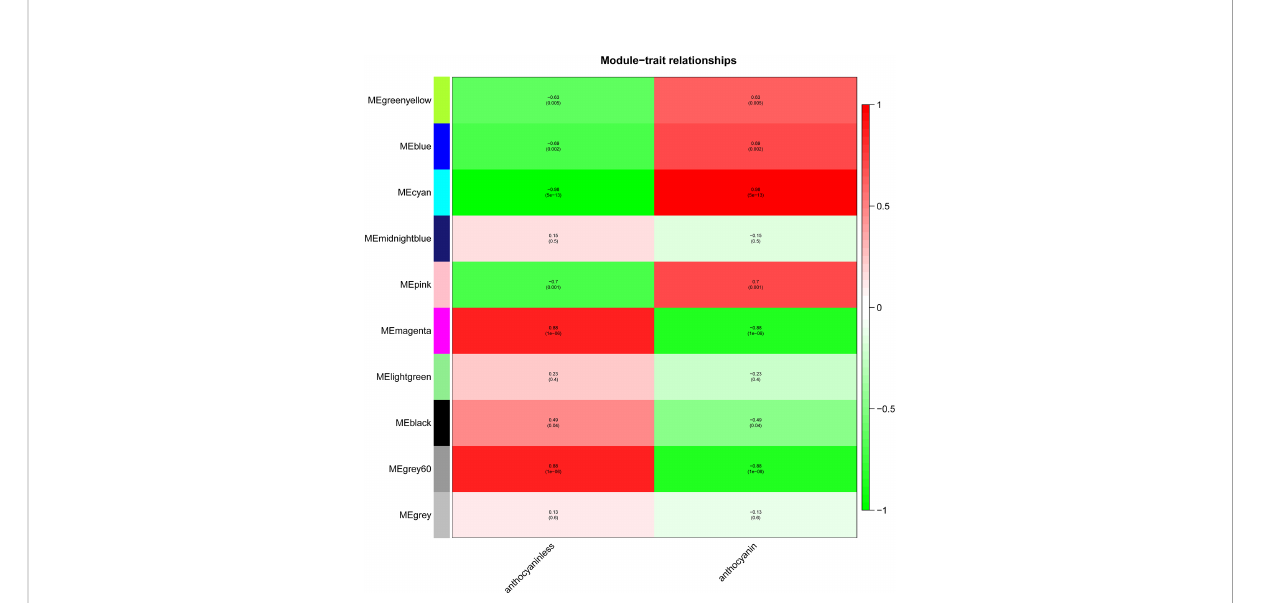
FIGURE 3 The module-trait relationship between transparent and anthocyanins biosynthesis pericarps. The anthocyanin indicated the pericarp with anthocyanin biosynthesis and accumulation. The anthocyaninless represented the transparent